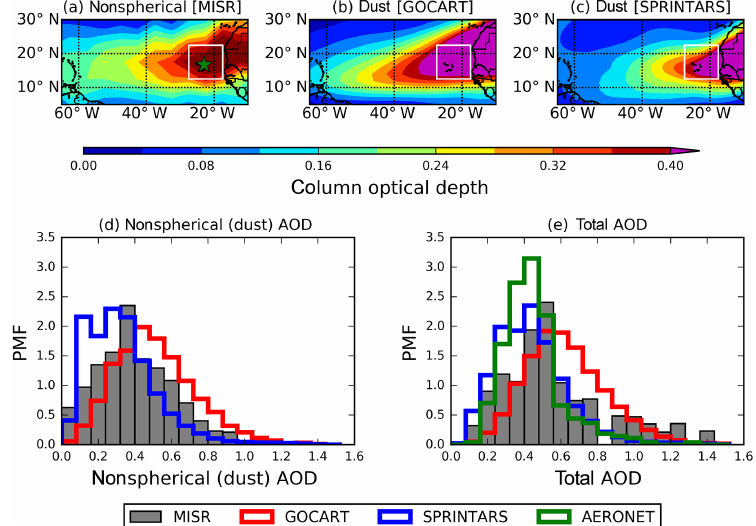
Figure 4. (a) Climatological mean optical depth of the nonspherical aerosols in MISR, dust AOD in (b) GOCART, and (c) SPRINTARS over the eastern Atlantic for July. Data from the eight Julys between 2000 and 2007 are averaged for MISR and GOCART. Spatiotemporal distri- butions of (d) the nonspherical (or dust) AOD and (e) total AOD from MISR (gray bars), from GOCART (red lines), and from SPRINTARS (blue lines), covering the boxed region (112.5–122.5 ◦ E, 32.5–37.5 ◦ N) off the coast are displayed. The green star in (a) displays a location of the AERONET station in Cabo Verde. The green line in (e) represents the total AOD distribution in Cabo Verde for July 2005.